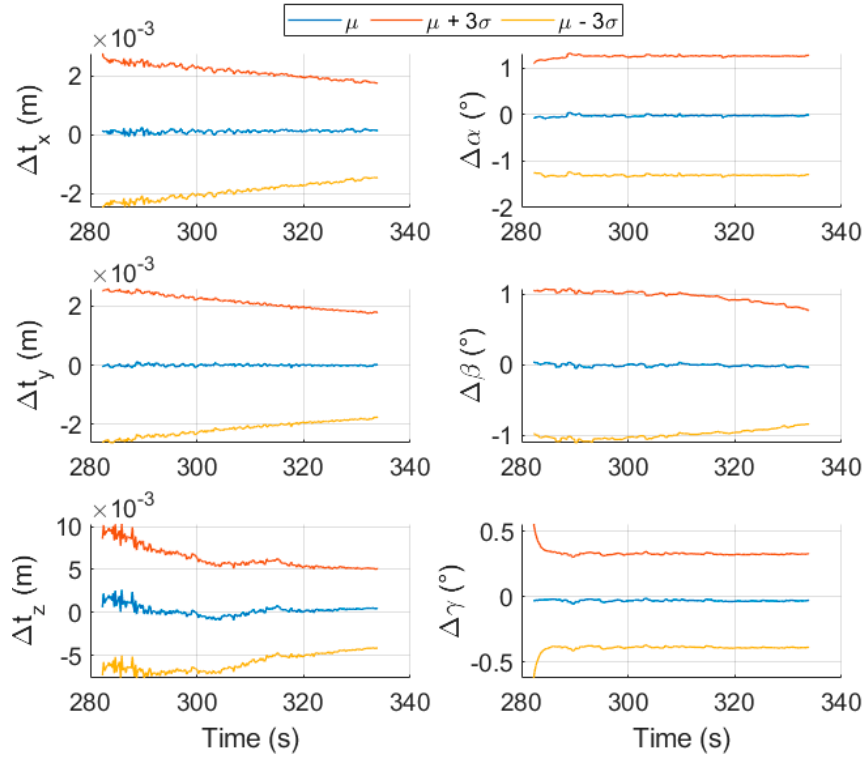
Figure 26. Temporal evolution of the mean of the errors on the pose parameters, with representation of the 3 σ intervals, for test